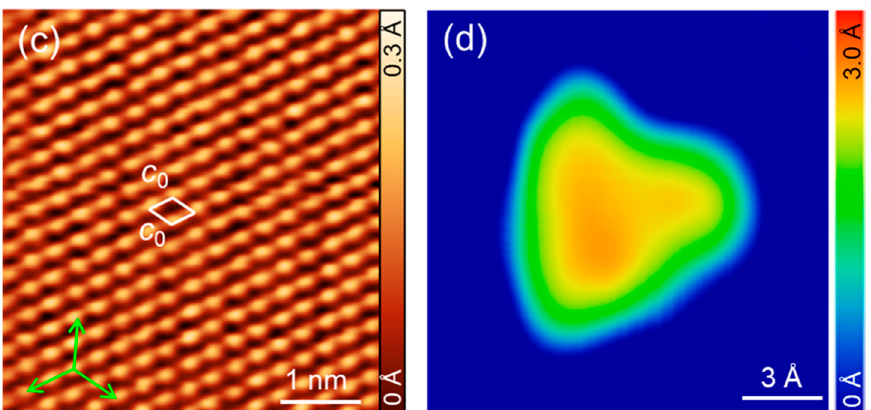
Figure 1. Isolated TPB molecule adsorbed on Cd(0001). ( a ) Chemical structure of TPB molecule. ( b ) Morphology of the Cd(0001) thin films grown on a Si(111)-7 × 7, 3.0 V, 20 pA. ( c ) Atomic-resolution STM image showing the hexagonal lattice of the Cd(0001) thin film, 0.06 V, 20 pA. ( d ) STM image of an isolated TPB molecule adsorbed on Cd(0001), revealing a three-lobe motif, 0.9 V, 20 pA.